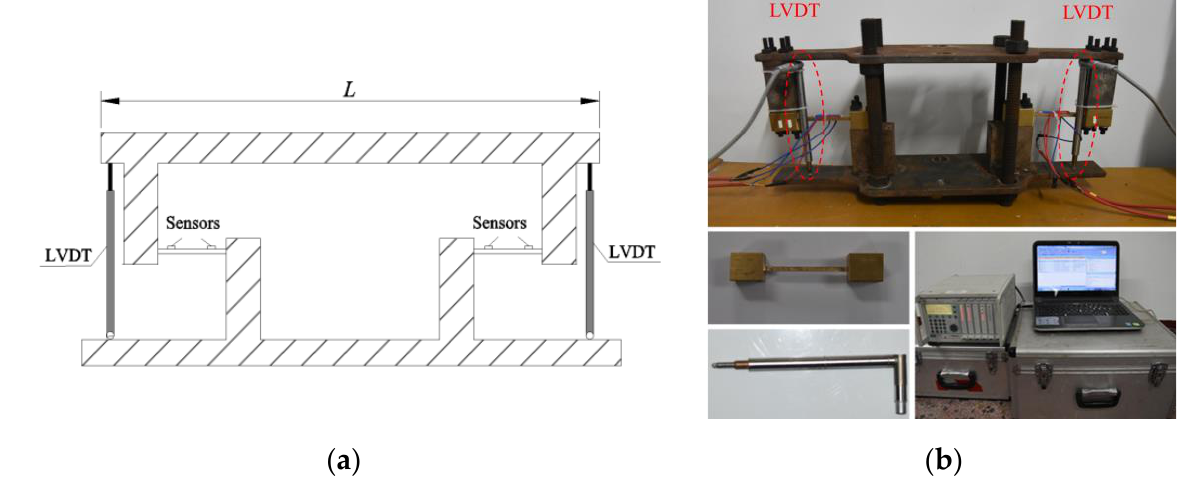
Figure 6. ( a ) Schematic illustration and ( b ) laboratory setup of the calibration test.